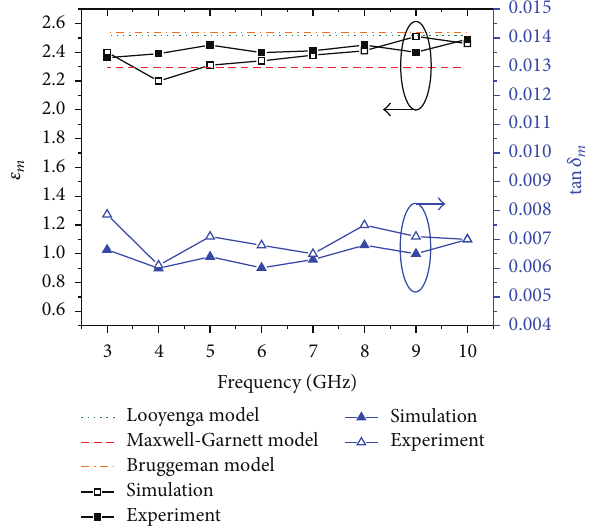
Figure 10: Theoretical, experimental, and simulated results of 𝜀 𝑚 and tan 𝛿 𝑚 at the center frequency, 12.5 GHz, with different packing depth 𝐻 of the